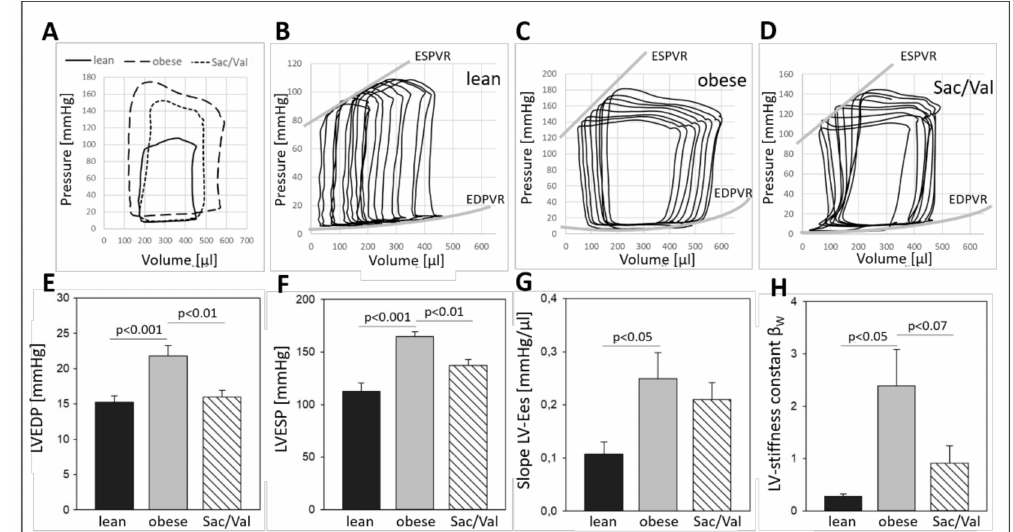
Figure 4. LV hemodynamic conditions and compliance after 12 weeks of Sac/Val treatment. Representative baseline Pressure-Volume (PV) loops of lean, obese, and Sac/Val treated rats at an age of 32 weeks ( A ). Representative PV loop shifts in response to a transient occlusion of the inferior vena cava of a lean ( B ), an obese ( C ), and a Sac/Val treated obese rat ( D ). ( E ) Comparison of LV end diastolic pressure (LVEDP) and ( F ) LV end systolic pressure (LVESP) at baseline conditions. Comparison of the LV contractility indicated by the slope LV-Ees obtained by the end-systolic pressure-volume relationships (ESPVR) ( G ). Comparison of the LV chamber stiffness indicated by the LV stiffness constant β W ( H ) obtained by the end-diastolic pressure-volume relationships (EDPVR). n = 10–12. To test the effect of Sac/Val, one-way analysis of variance (ANOVA) followed by Bonferroni post hoc was used to compare